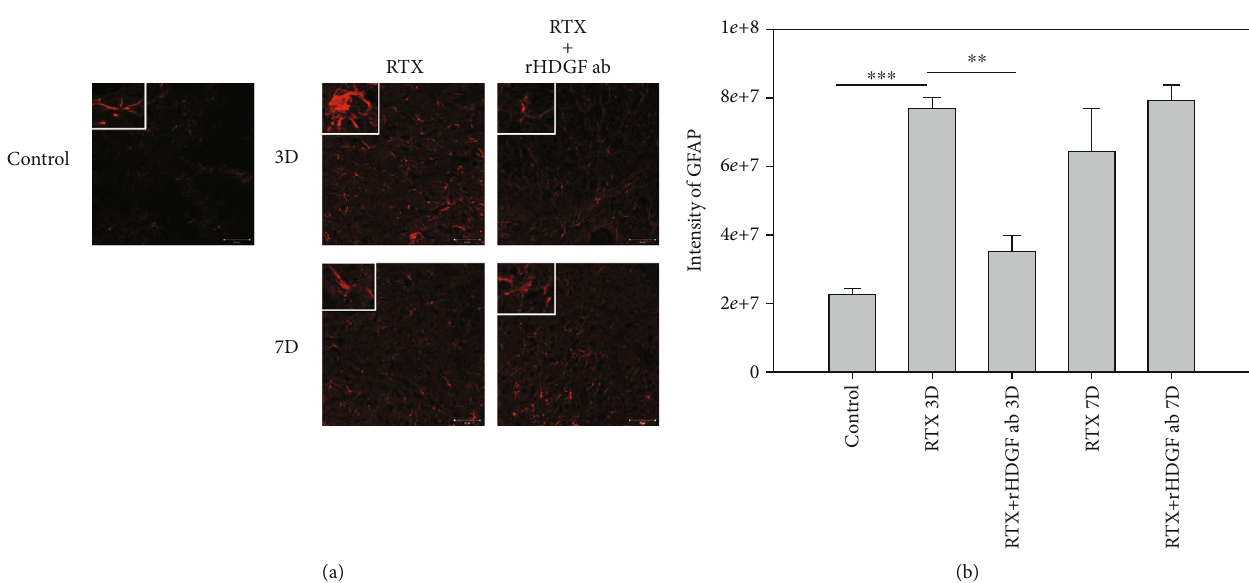
Figure 2: E ff ect of rHDGF antibody on astrocytes in the L3/L5 spinal cord dorsal horn (laminae I-II) of RTX-treated rats. After the rats were divided into three groups, neuropathy was induced by intraperitoneally administration of a single dose of RTX (50 μ g/kg). In the RTX +rHDGF antibody group, 100 μ g/kg rHDGF antibody was administered and applied 24 hours before RTX injection. The control group received no rHDGF antibody pretreatment and no RTX injection. At 3 or 7 days after RTX injection and/or pretreated with rHDGF antibody, L3-L5 spinal cord dorsal horn were harvested, and the proliferation of astrocytes (GFAP) was detected through immuno fl uorescence staining (200x magni fi cation). (a) Representative immuno fl uorescence staining image shown are from 3 to 5 sections stained at least from 6 rats for each group. White rectangle in (a) indicates the astrocyte morphology for high magni fi cations. (b) Changes in intensity. ∗∗ P < 0 : 01 , ∗∗∗ P < 0 : 001 . Data are expressed as the mean + SEM ( n = 6 per